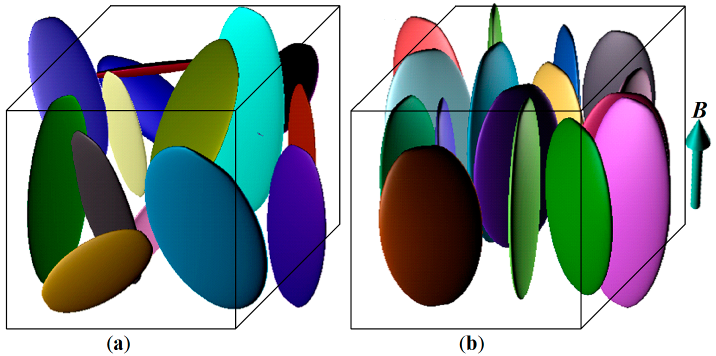
Figure 10. Schematic diagrams showing the alignments of the plate-shaped primary zinc-rich crystals ( a ) without and ( b ) with a HMF, respectively. The arrow in (b) indicates the direction of B